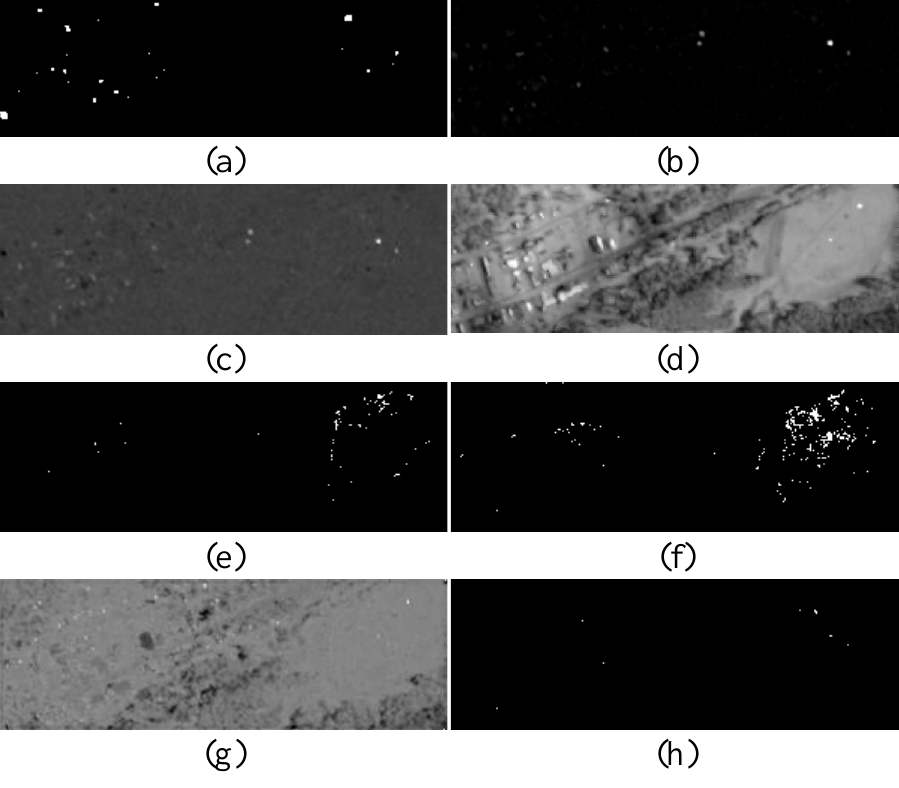
Figure 13. Detection maps for the HyMap dataset when p f is fixed to 0.15: ( a ) CEM p d = 0.55. ( b ) ACE p d = 0.59. ( c ) MF p d = 0.71. ( d ) SLMD p d = 0.80. ( e ) OC-SVM p d = 0.79. ( f ) SRD p d = 0.86. ( g ) CSCR p d = 0.62. ( h ) Lp-SRD p d =